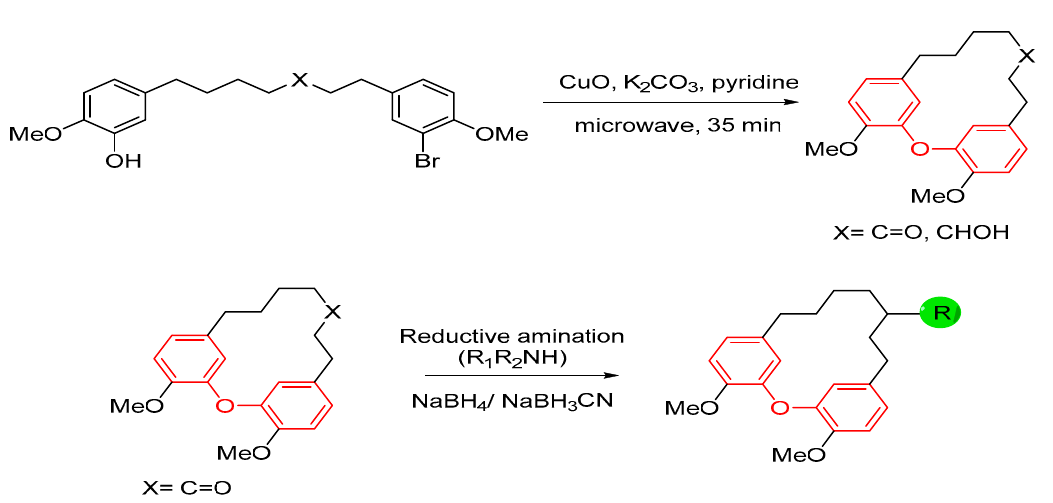
Scheme 52. Synthesis pathway of macrocyclic amine derivative via Ullmann coupling reaction.